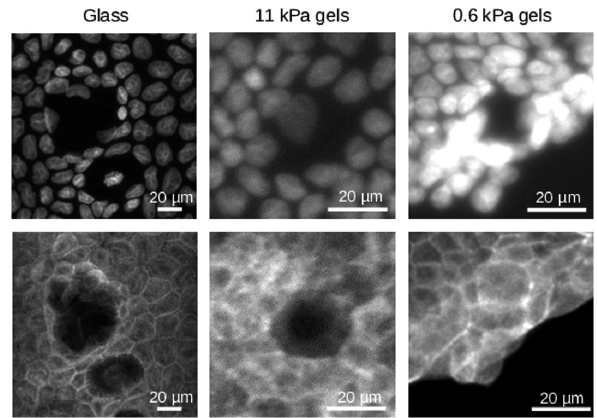
FIG. 18. Scars left by extrusion events in the tissue. We show pictures of scars left by extrusion seen through nuclei pictures (top) and actin pictures (bottom) for cells grown on glass, hard 11 kPa gels, and soft 0.6 kPa gels.